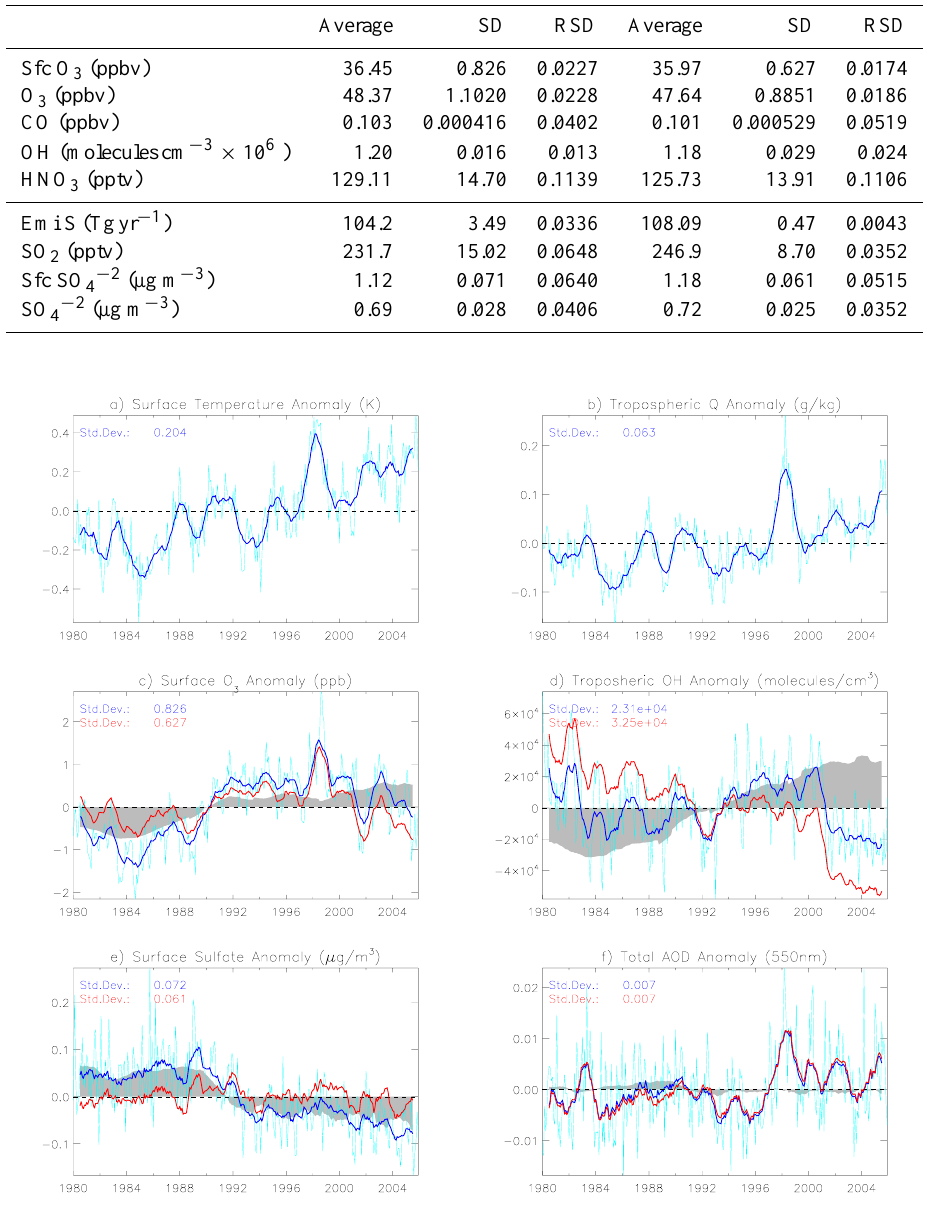
Fig. 4. Monthly mean anomalies for the period 1980–2005 of globally averaged fields for the SREF and SFIX ECHAM5-HAMMOZ simulations. Light blue lines are monthly mean anomalies for the SREF simulation, with overlaying dark blue giving the 12 month running averages. Red lines are the 12 month running averages of monthly mean anomalies for the SFIX simulation. The grey area represents the difference between SREF and SFIX. The global fields are respectively: (a) surface temperature (K); (b) tropospheric specific humidity (gKg − 1 ); (c) O 3 surface concentrations (ppbv); (d) OH tropospheric concentration weighted by CH 4 reaction (moleculescm − 3 ); (e) SO 2 − surface concentrations (µgm − 3 ); (f) total aerosol optical